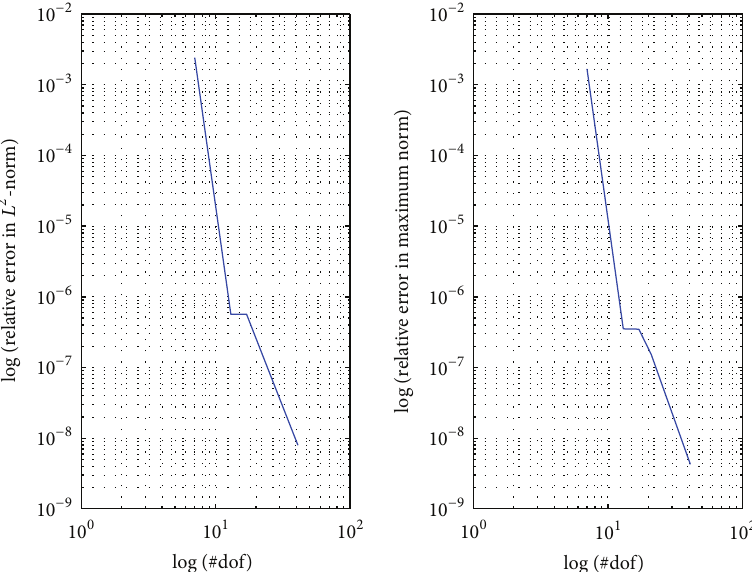
Figure 2: Convergence graphs of relative error in 𝐿 2 -norm and maximum norm via Sloan iteration for (42) in Example